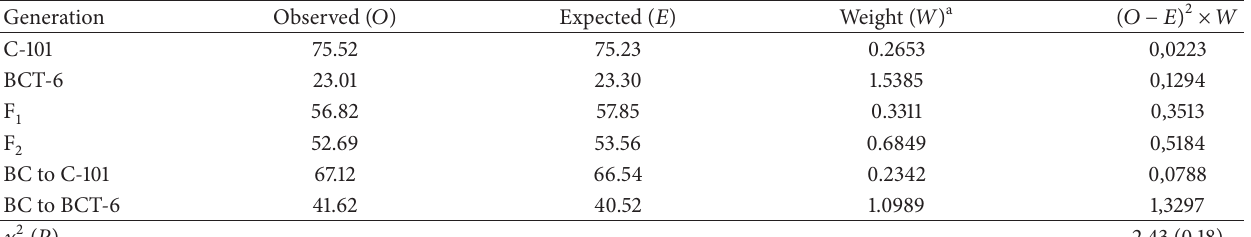
Table 4: Goodness of fit of the additive-dominance model for 𝛾 -tocopherol content in the cross between the Ethiopian mustard lines BCT-6, with reduced 𝛾 -tocopherol content, and C-101, with conventional levels of 𝛾 -tocopherol. Generation